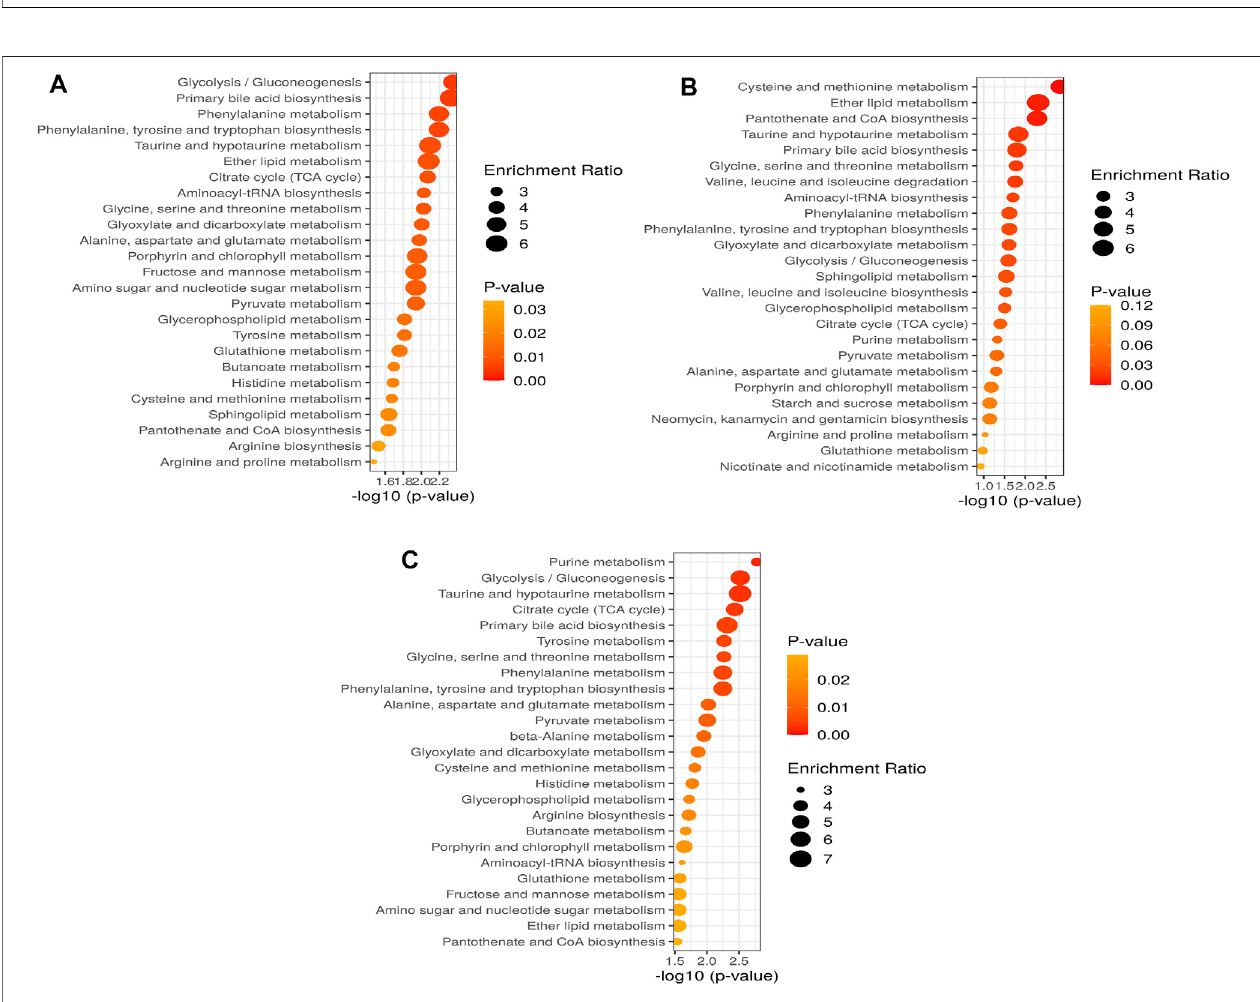
FIGURE 5 | Altered metabolic pathways and performance of the automated assignment in zebra fi sh in (A) 10 mg/L; (B) 50 mg/L; (C) 100 mg/L. The differential metabolites identi fi ed by all studies under review were enriched into pathways using MetaboAnalyst software (version 5.0; www.metaboanalyst.ca). Pathways where metabolite sets are ranked according to p -value with hatched lines indicating Holm p -value threshold.